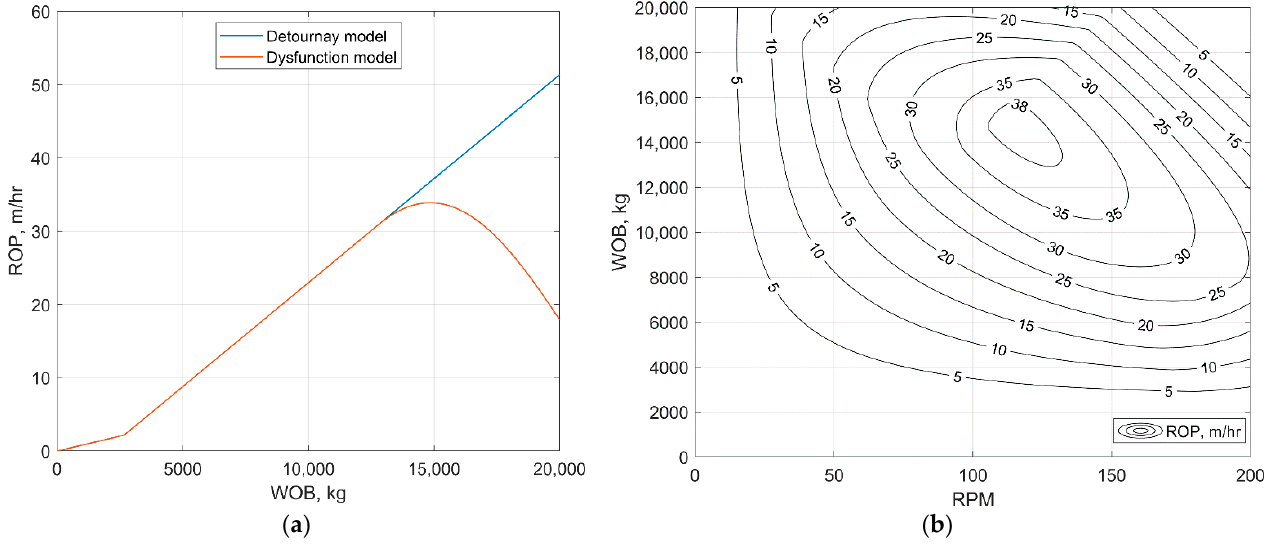
Figure 3. Drilling response with the drilling model including dysfunctions in formation A . ( a ) Drill-off curve for a constant RPM value of 90; ( b ) Contour plot of ROP (m/h) as a function of WOB and RPM with the extended model.